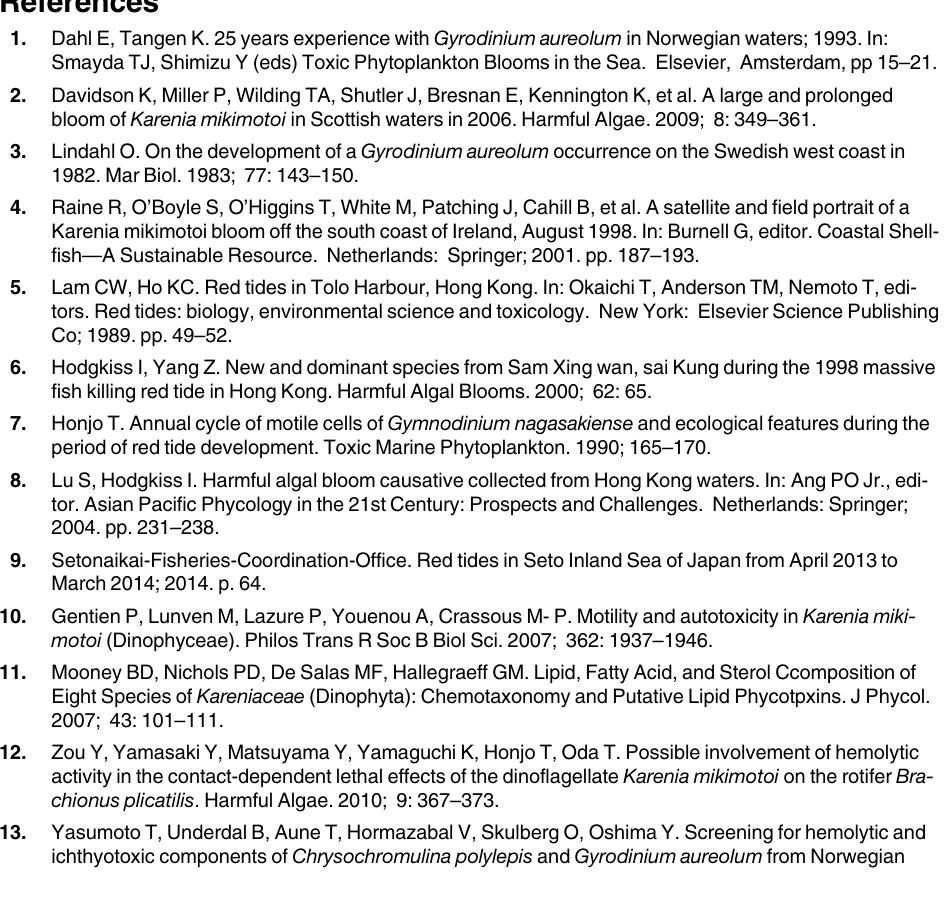
according to the KS domain by using the neighbor joining (NJ) method using MEGA 6.0 soft- ware. Bootstrap values (%) from 100 samples are shown at the nodes in each tree. NJ distance scale bars are shown under the trees. S1 Table. Taxonomic distribution of BLASTx top hit to K . mikimotoi